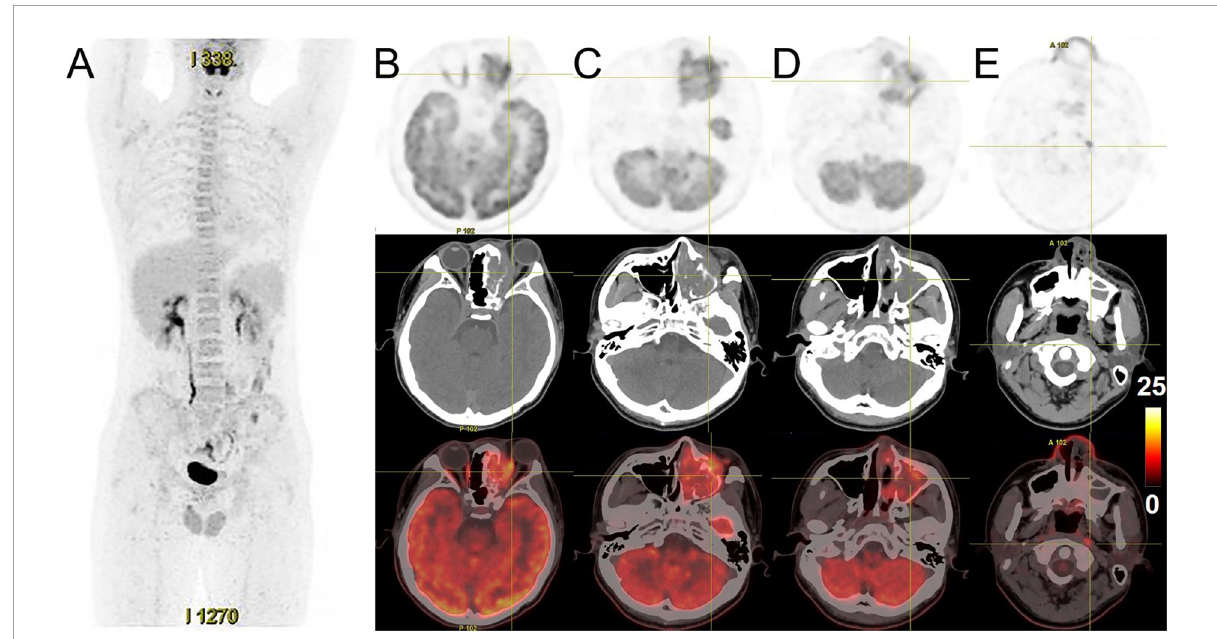
FIGURE6 18 F-FDG PET/CT images of nasal sinus ARMS in case 2. (A) The anteroposterior 3-dimensional MIP image demonstrated FDG-avid lesions located in the left maxillofacial region, without abnormal FDG metabolism. (B–D) The transverse images showed soft tissues existed in the left ethmoidal sinus, the left maxillary sinus, and the left nasal cavity, with high radioactivity distribution, SUVmax at about 19.1. The lesions invaded the left orbit without clear edges from the left abducens oculi, and bone destruction could be seen in the left ethmoidal-lamina papyracea, medial orbital wall, and maxillary sinus. (E) The transverse images showed a lymph node with elevated uptake of SUVmax at about 9.7 in the left parapharyngeal regions.